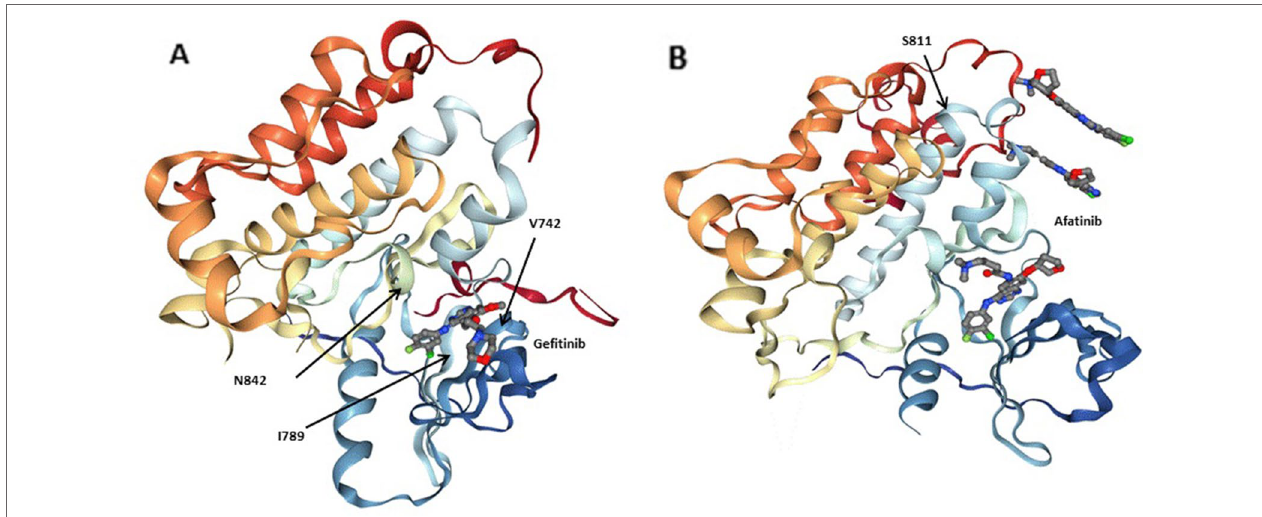
FIGURE 3 | Three-dimensionional (3D) models of (a) the EGFRQ. kinase domain-Gefitinib complex structure (PDB: 2ITY), (B) the EGFR kinase domain-Afatinib complex structure (PDB: 4G5J). Gefitinib and Afatinib are shown as sticks. Residues at the mutation site of the EGFR kinase domains (V742, I789, N842 and S811) are shown with